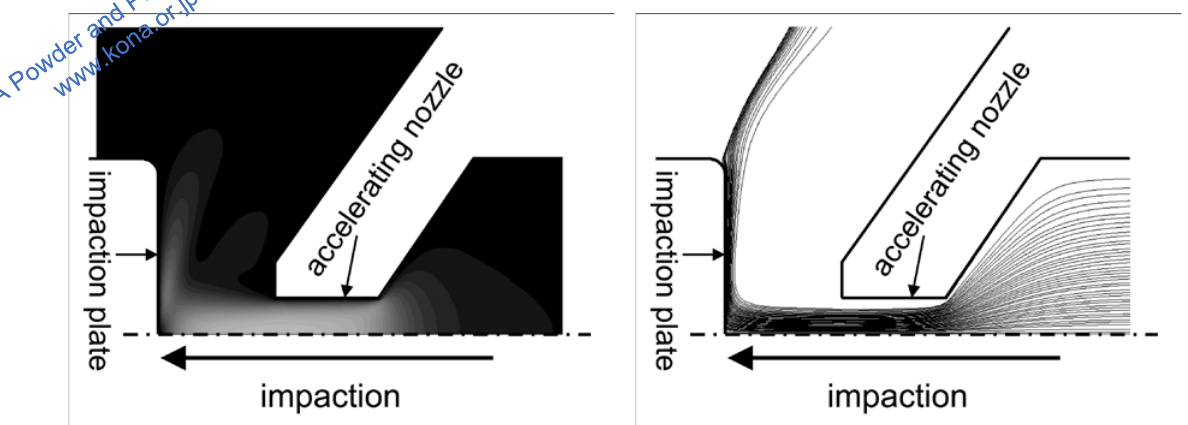
Fig. 6 Simulation results of impaction with 521-nm DEHS droplets by 3600 Pa using the classic Cc (left: gas flow; right: particle trajectories, the particle velocity is highest on the central axis and close to the gas velocity of 37